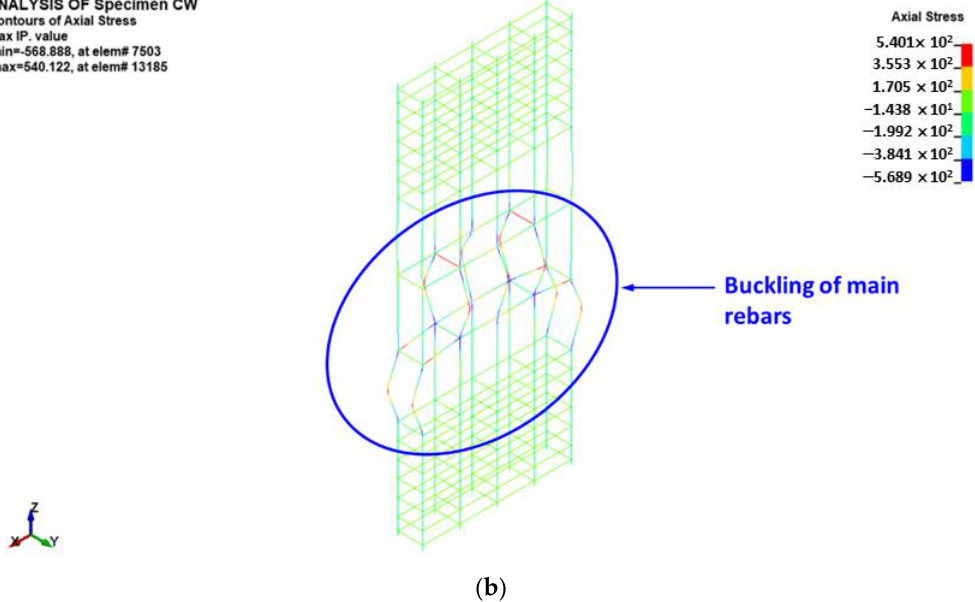
Figure 21. FE mode of failure for control specimen CW: ( a ) effective plastic stress contours for concrete elements; ( b ) axial stress contours for rebar elements.